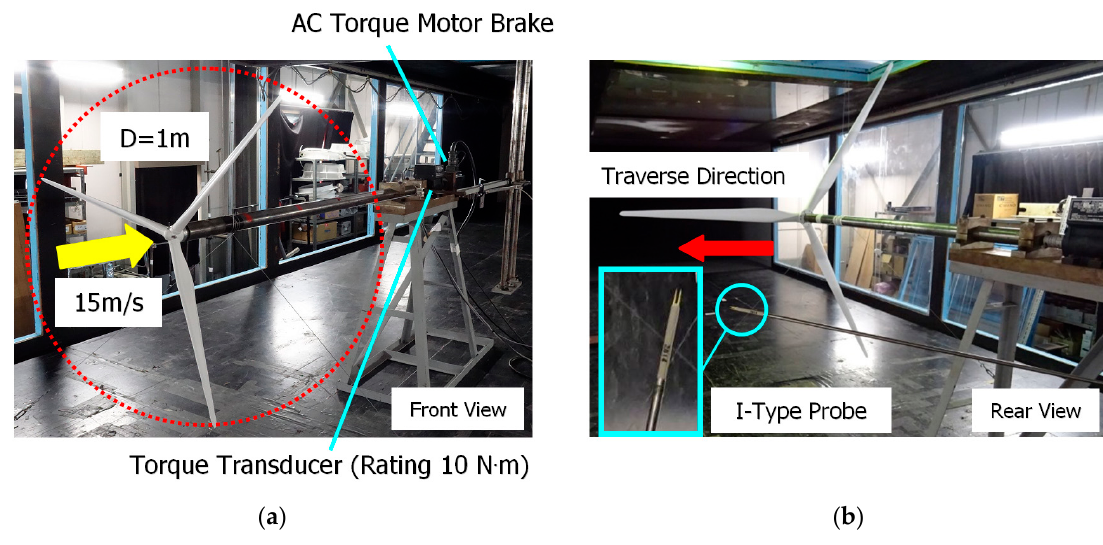
Figure 4. The 1/88 wind turbine scale model used in the present study. ( a ) Front view; ( b ) rear view.